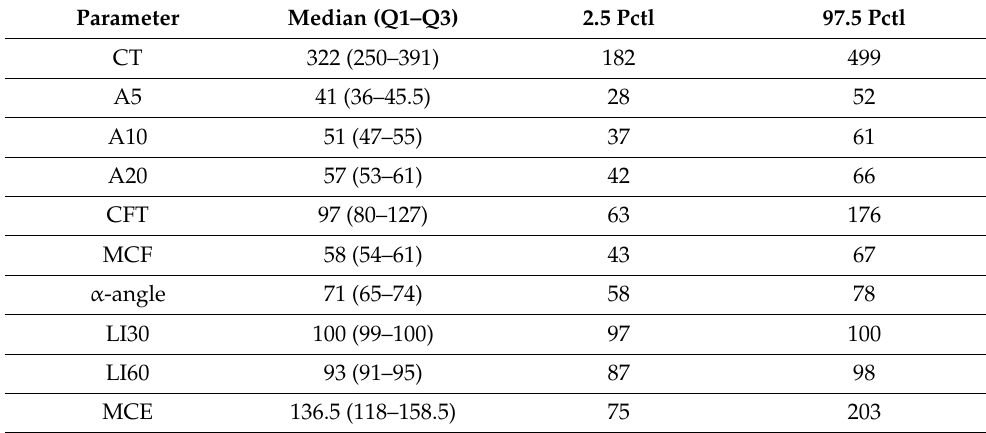
Table 2. Reference ranges of NATEM parameters ( N = 189).